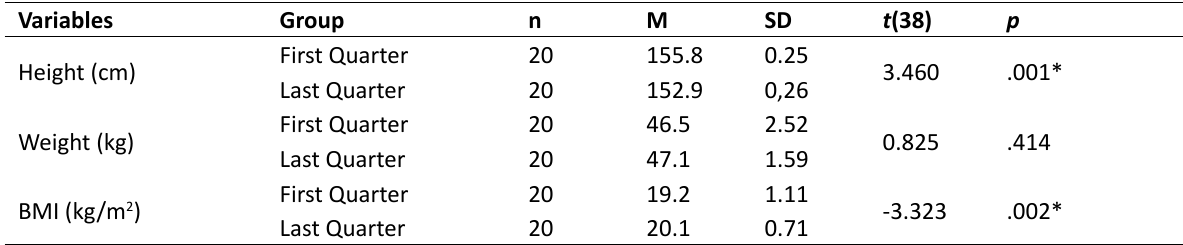
Table 1. The comparison of physical characteristics between the relative age groups. Variables